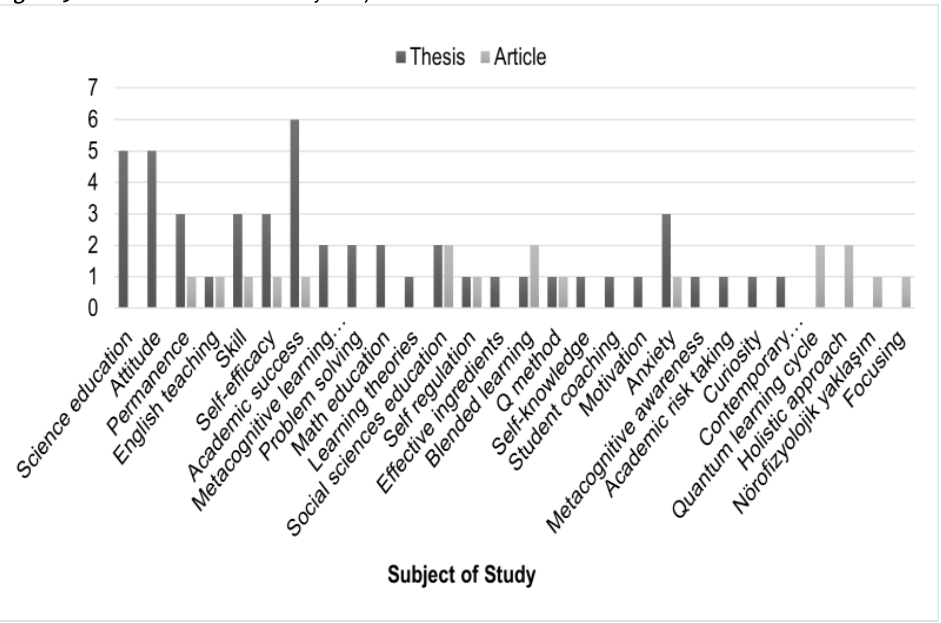
Figure 9: Distribution of Studies by